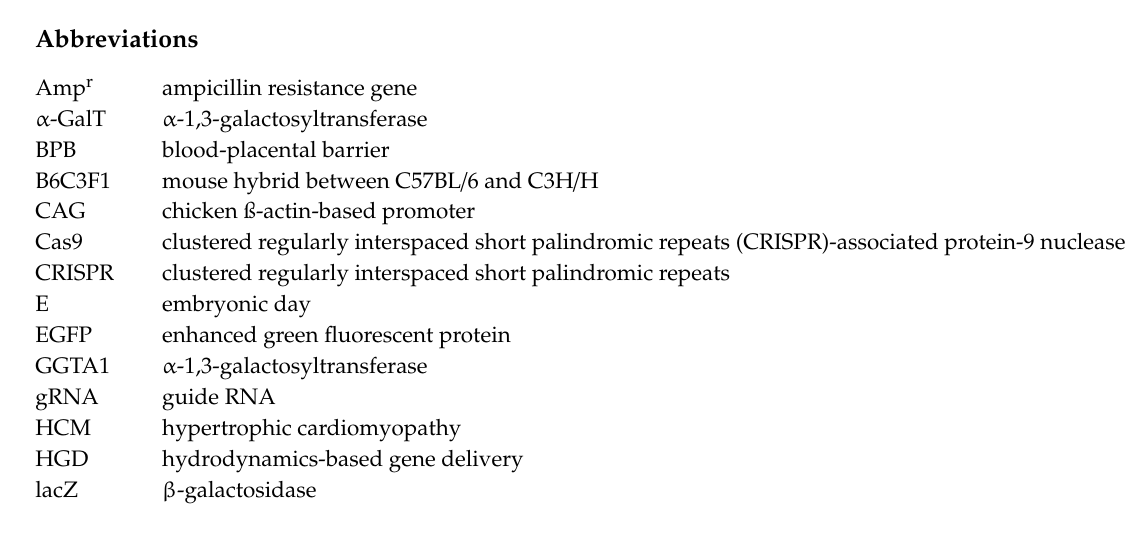
Table S1: Summary of analysis of fetuses obtained after HGD-based TPGD-GEF on E9.5, 12.5 or 15.5. Table S2: Nucleotide sequences of a region spanning a sequence recognized by gRNA in pCGSap1- MHC α in sub-clones from #a-1, #a-3, #a-4, and #a-7 samples. Figure S1: PCR analysis of genomic DNA isolated from fetal samples (#a-1 to -10) derived from recipient #A (Figure 2; Table S1). Figure S2: Sequencing of PCR products derived from the genome-edited fetuses sub-cloned into a pTA cloning vector. Figure S3: O ff -target analysis of 2 candidate genes for fetal hearts exhibiting